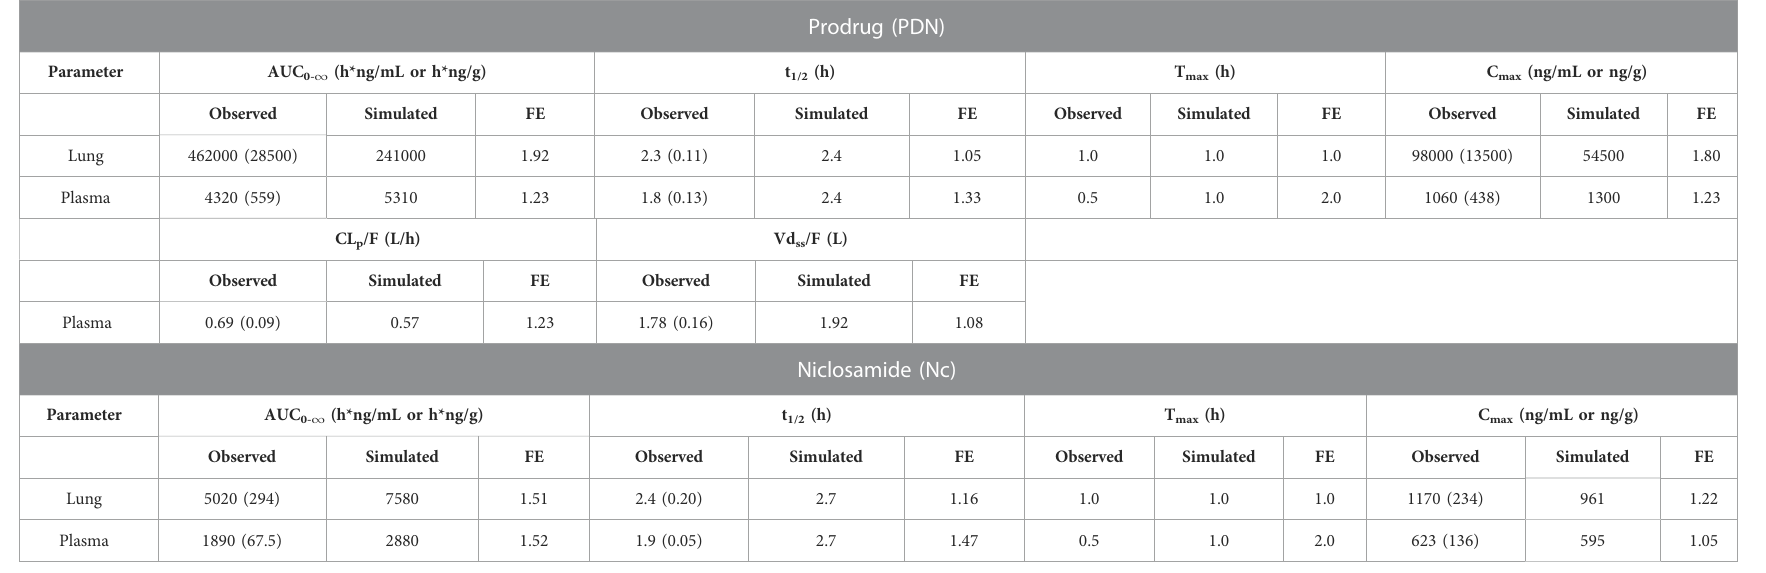
TABLE 7 Observed and simulated pharmacokinetic parameters of PDN and Nc in plasma and lung tissues after PO dose of 30 mg/kg PDN in hamsters. Data were presented as mean (SD).